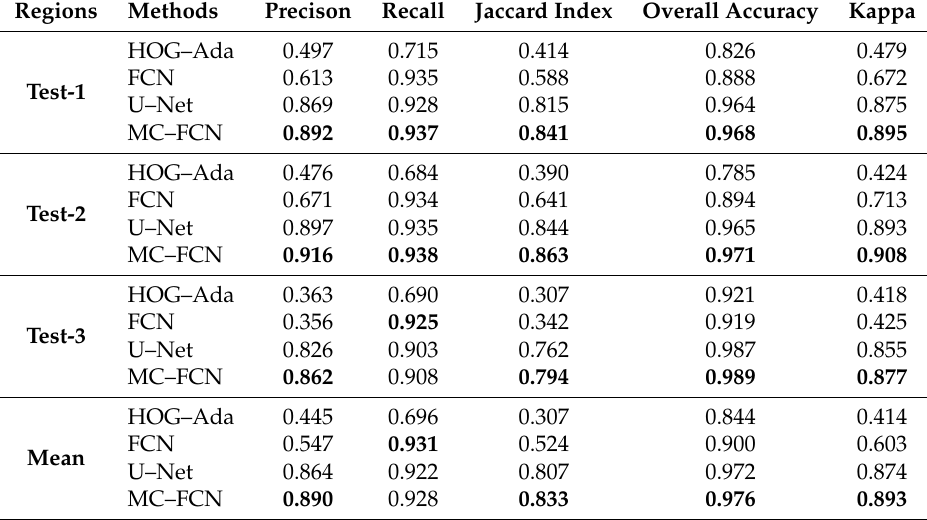
Figure 7. Representative results of building segmentation through the U–Net and MC–FCN methods. The green, red and blue channels of results represent true positive, false positive and false negative predictions, respectively, of every pixel. Table 5. Comparison of performance of HOG–Ada, FCN, U–Net and MC–FCN in Test-1, Test-2 and Test-3 regions. For every test region, the highest values for different metrics are highlighted in bold